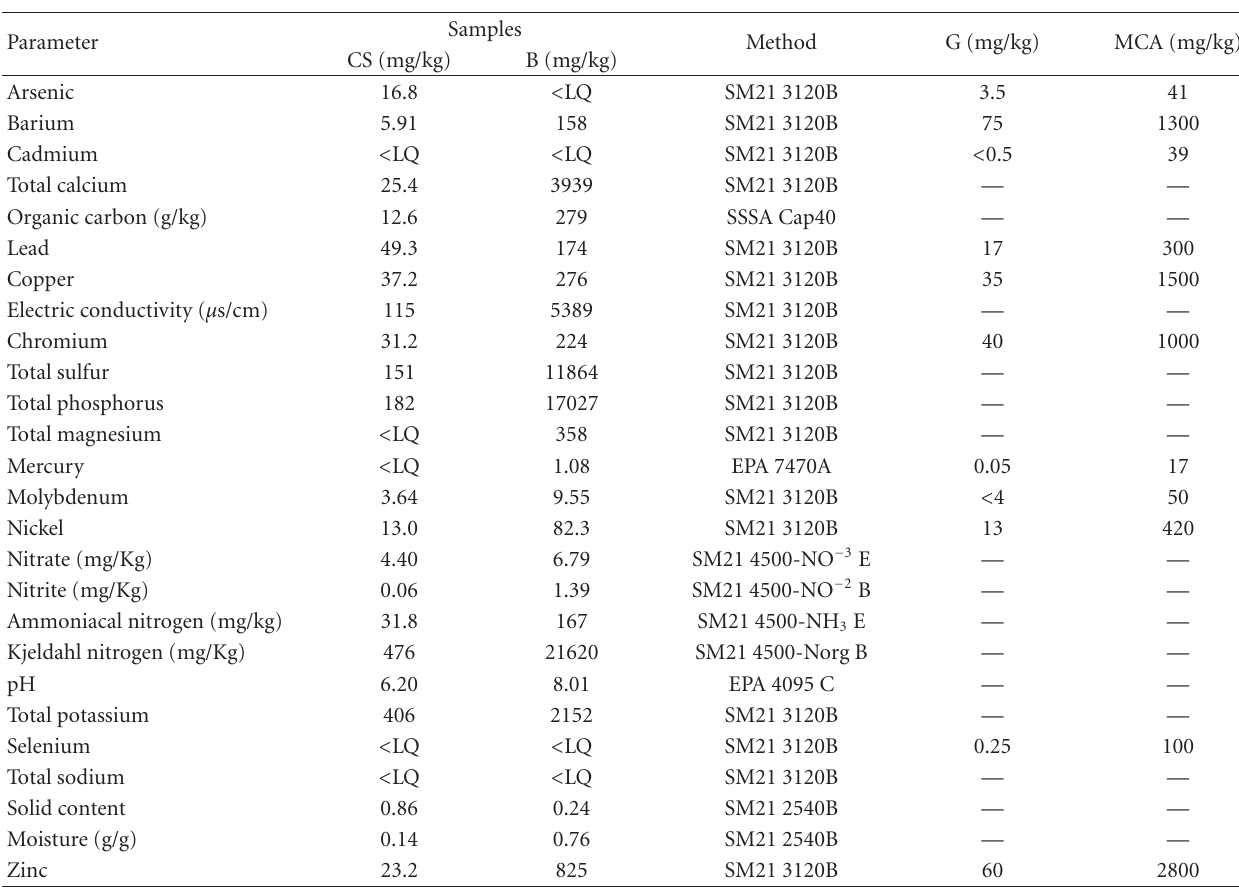
Table 2: Physicochemical and metal analysis of the control soil and biosolid sample.